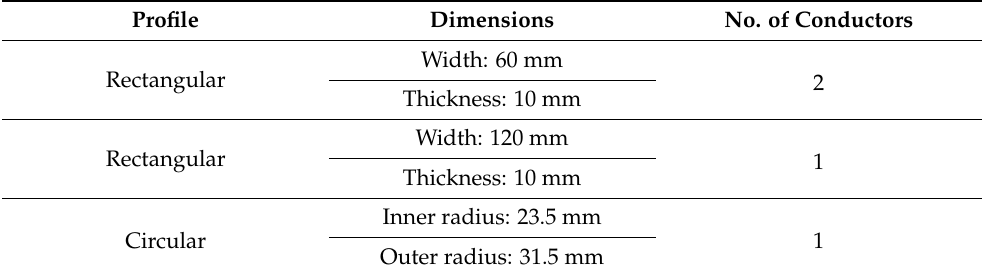
Table 3. Busbar dimensions.